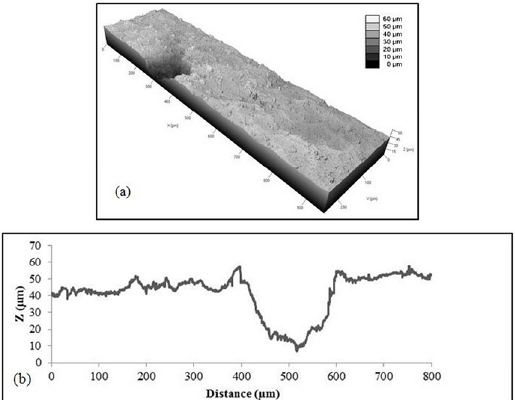
Figure 7. (a) Topography of the specimen, after 60 days of immersion in a two-phase system; (b) Roughness profile.